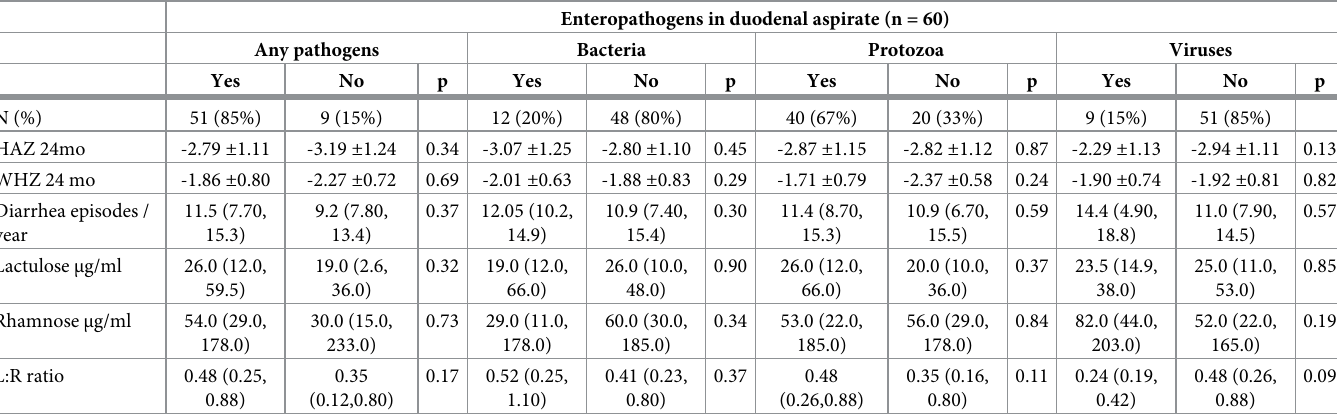
Table 3. Summary of the enteropathogen in the duodenal aspirate and its association with HAZ, morbidity and dual sugar urinary excretion in cases.